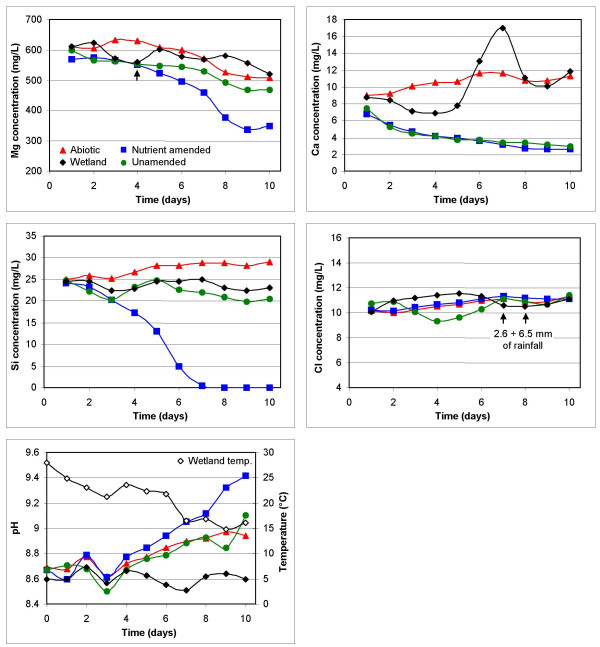
Graphs showing changes in [Mg2+], [Ca2+], [Si4+], [Cl-], and pH in the wetland (black diamonds), abiotic control (red triangles), unamended (green circles), and amended microbial mat (blue squares) microcosms with time. The data is presented as a 2-day moving average. The arrow on the Mg-graph indicates the day when new microbial growth was seen as greening of the microbial mats in the amended microcosm. The arrows placed on the Cl-graph show the occurrences of two rainfall events on days 7 (2.6 mm) and 8 (6.5 mm). The pH graph also displays wetland temperature (black open diamonds), which matches microcosm temperatures.